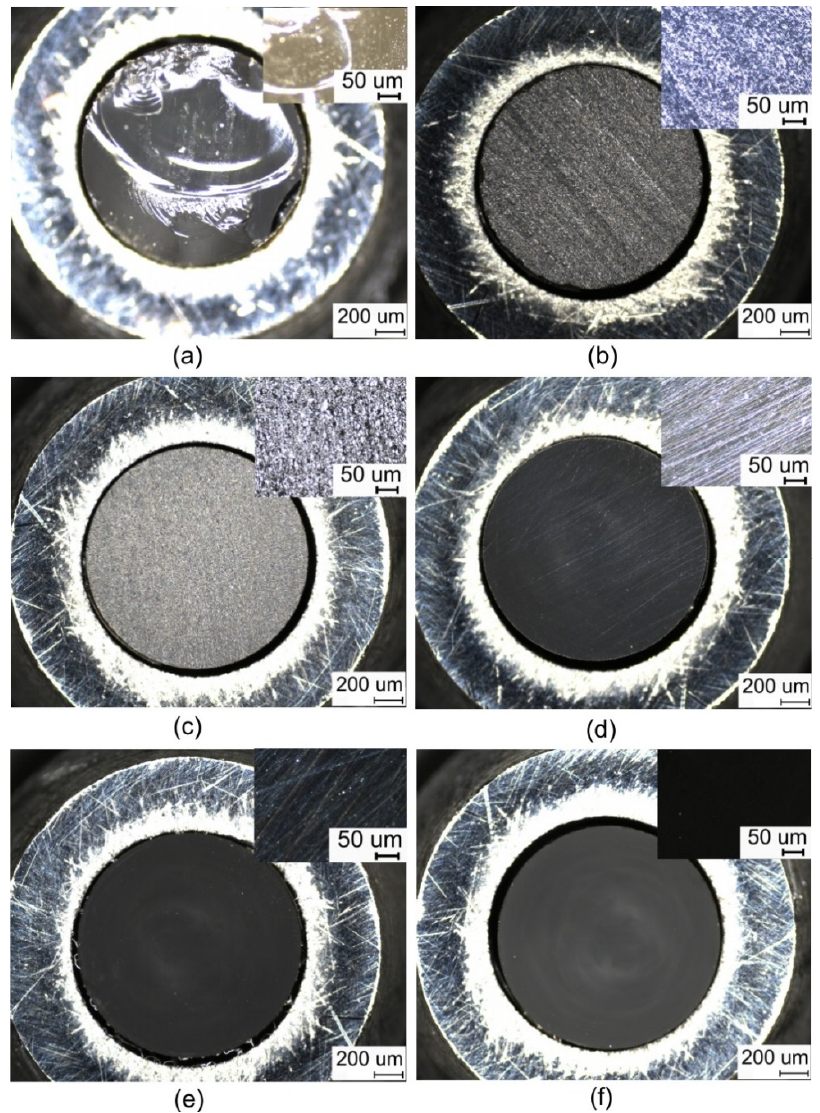
Figure 2. The process of grinding/polishing optical fibres with a detailed section, ( a ) cleaved optical fibre, ( b ) polished with 30 µ abrasive paper, ( c ) polished with 6 µ abrasive paper, ( d ) polished with 3 µ abrasive paper, ( e ) polished with 1 µ abrasive paper, ( f ) polished with fine abrasive